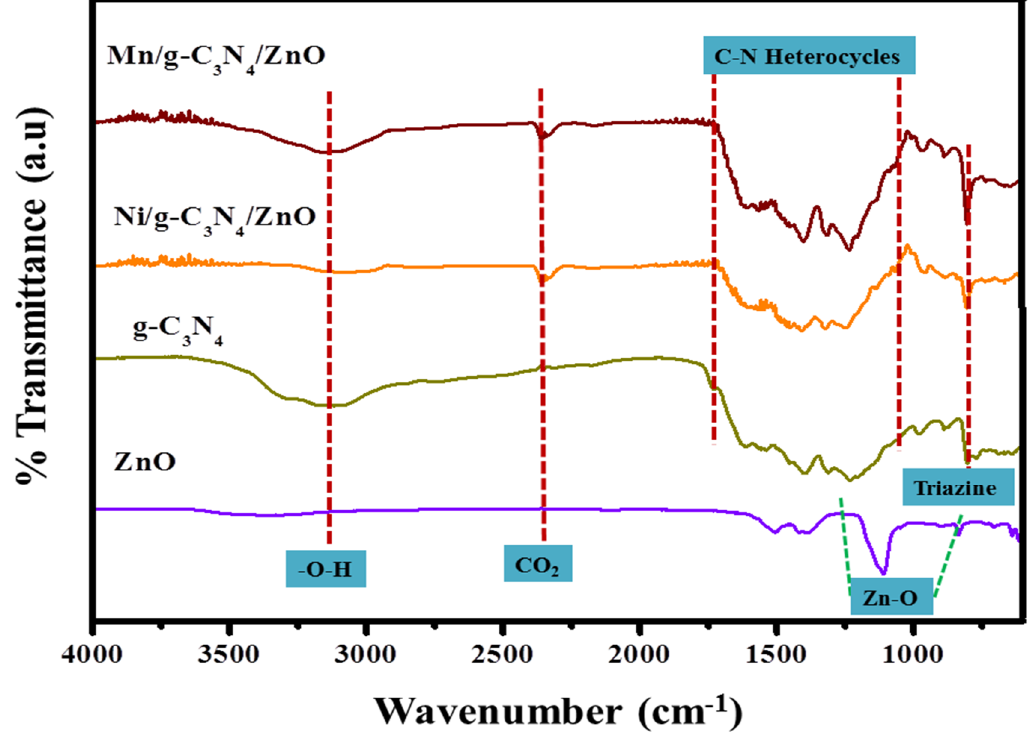
Figure 2. FTIR spectra of ZnO, g-C3N4, and (Ni/Mn)/g-C 3 N 4 /ZnO